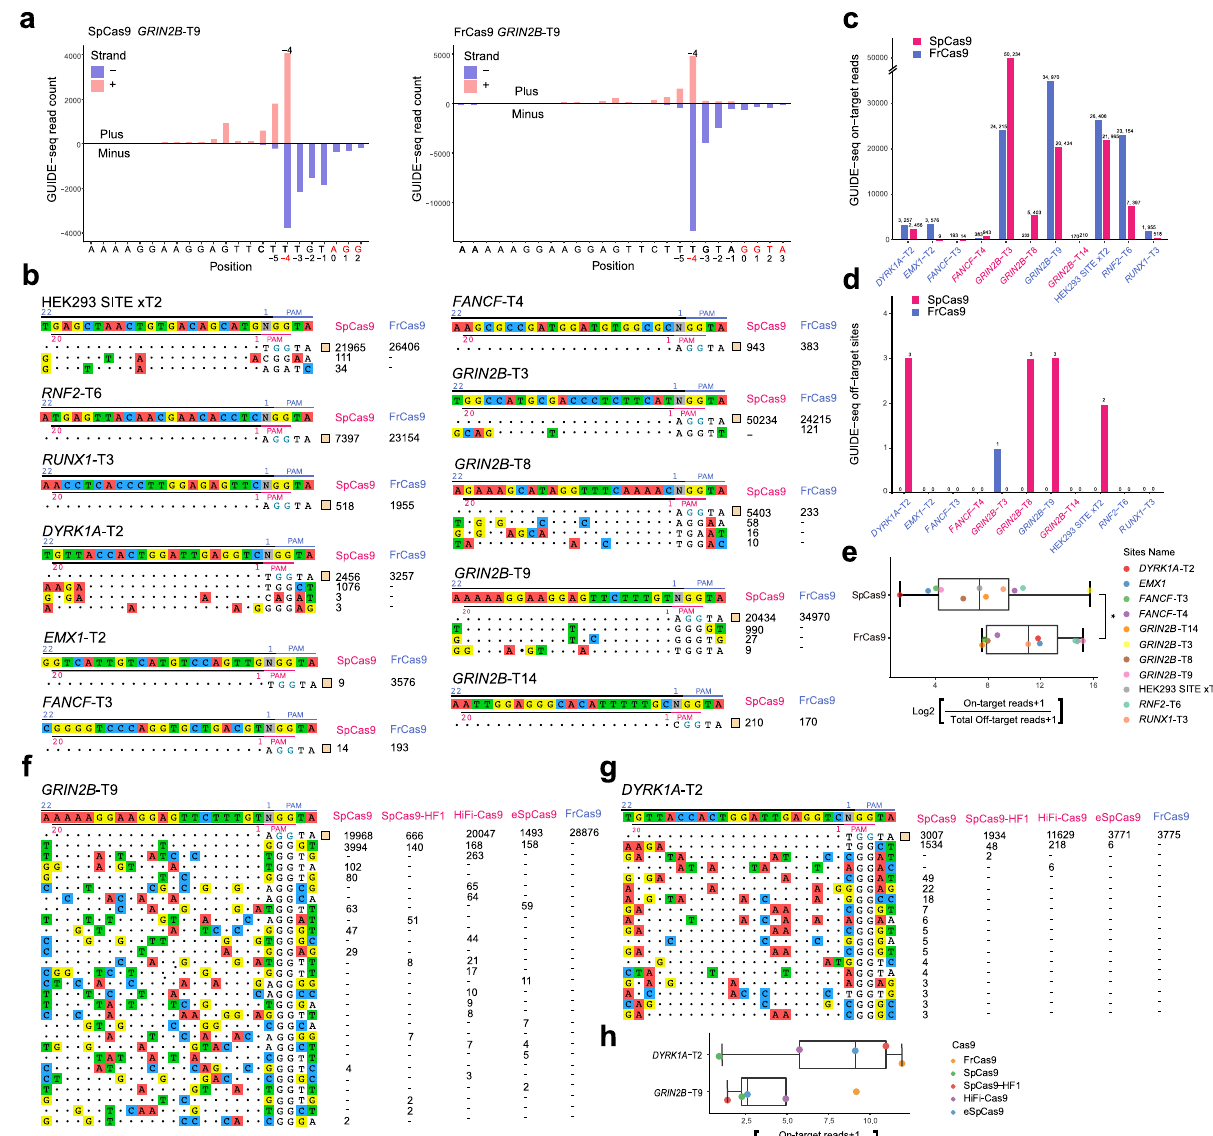
Fig. 3 The genome-wide speci fi cities of FrCas9 and SpCas9. a The start mapping positions of GUIDE-seq reads for SpCas9 and FrCas9 targeting GRIN2B - T9. The 1 st bases of PAM sequences (red) were position 0 and the most frequent dsODN incorporation sites were colored in red. b The off-targets of SpCas9 and FrCas9 for 11 sites, generated by GUIDE-seq in HEK293T cells. The sgRNA and PAM ranges of SpCas9 (20 nt sgRNA and 3 nt PAM) and FrCas9 (22 nt sgRNA and 4 nt PAM) were marked. GUIDE-seq read counts of each site were shown on the right side. c Summary of GUIDE-seq on-target reads of SpCas9 and FrCas9 at the above 11 sites. d Summary of off-target counts of SpCas9 and FrCas9 at the above 11 sites. e The on:off ratio of GUIDE- seq reads. N = 11 sites. Box plots indicate median (middle line), 25th, 75th percentile (box) and 5th and 95th percentile (whiskers). P = 0.032, two-sided Student ’ s t -test, * representing P < 0.05. f , g The off-targets of FrCas9, SpCas9, SpCas9-HF1, HiFi-Cas9 and eSpCas9 in DYRK1A -T2 ( f ) and GRIN2B -T9 ( g ) detected by GUIDE-seq in HEK293T cell line. h The on:off ratio of FrCas9, SpCas9, SpCas9-HF1, HiFi-Cas9 and eSpCas9 in DYRK1A -T2 and GRIN2B -T9. N = 5 Cas9 nucleases. Box plots indicate median (middle line), 25th, 75th percentile (box) and 5th and 95th percentile (whiskers). The ratio is de fi ned by GUIDE-seq on-target reads dividing total off-target reads. Source data are provided with this and RANKL (Fig. 5e). By cleaving the TATA-box, FrCas9 reduced ABCA1 , UCP3 and RANKL expression by 31.37%, 49.91% and 39.62%, respectively. Meanwhile, the expression of ABCA1 , UCP3 and RANKL decreased 61.67%, 45.61% and 42.60% by dFrCas9 directly binding to the TATA-box, respectively (Fig. 5f).